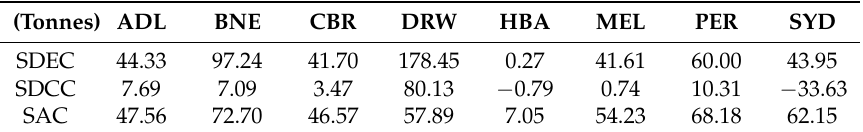
Table 10. Annual CO 2 emissions